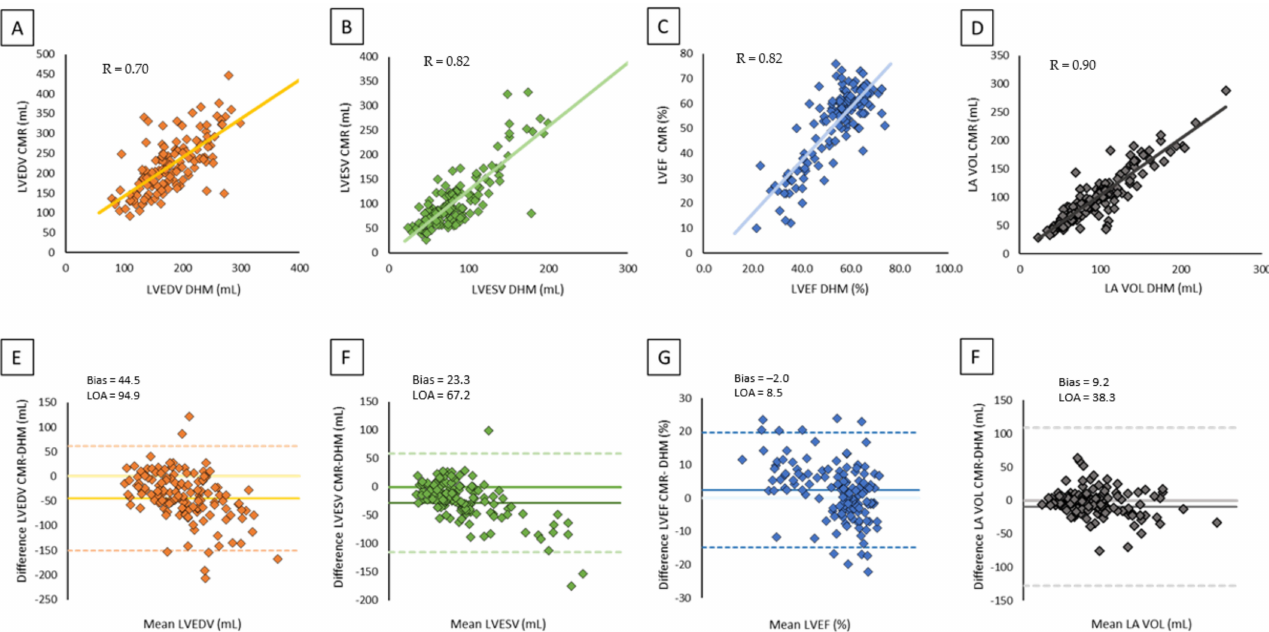
Figure 3. Correlation and agreement between CMR and DHM on left chamber volumes and LV function: ( A ) scatter plot of LVEDV by CMR versus DHM, ( B) scatter plot of LVESV by CMR versus DHM, ( C ) scatter plot of LVEF by CMR versus DHM, ( D ) scatter plot of LA volume by CMR versus DHM, ( E ) Bland–Altman plot of LVEDV by CMR versus DHM, ( F ) Bland–Altman plot of LVESV by CMR versus DHM, ( G ) Bland–Altman plot of LVEF by CMR versus DHM, ( H ) Bland–Altman plot of LA volume by CMR versus